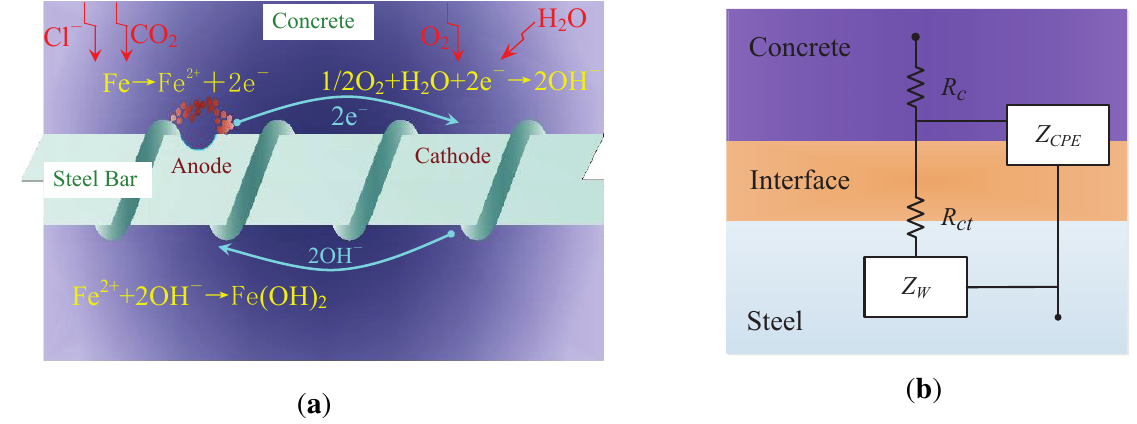
Figure 2. The basic principle of the steel’s corrosion process [4] with the deficit representing the corrosion ( a ) and the equivalent circuit ( b